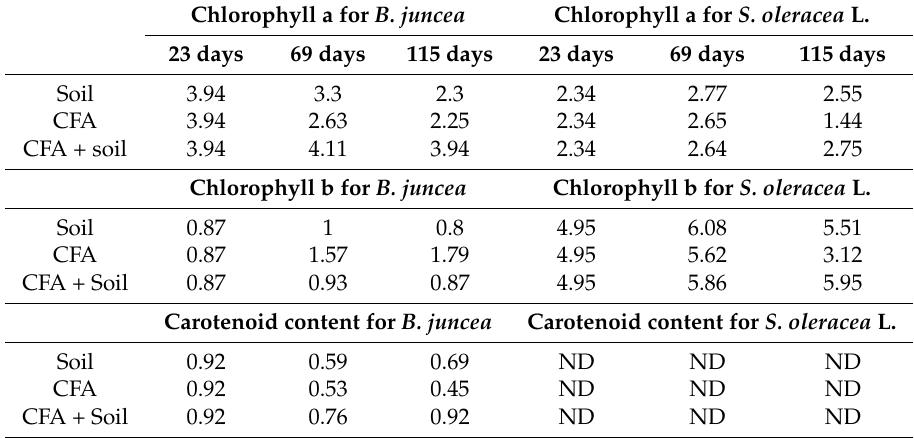
Table 2. Chlorophyll a and b content of S. oleracea L. and B. juncea for different growth media with time. Chlorophyll a for B. juncea Chlorophyll a for S. oleracea